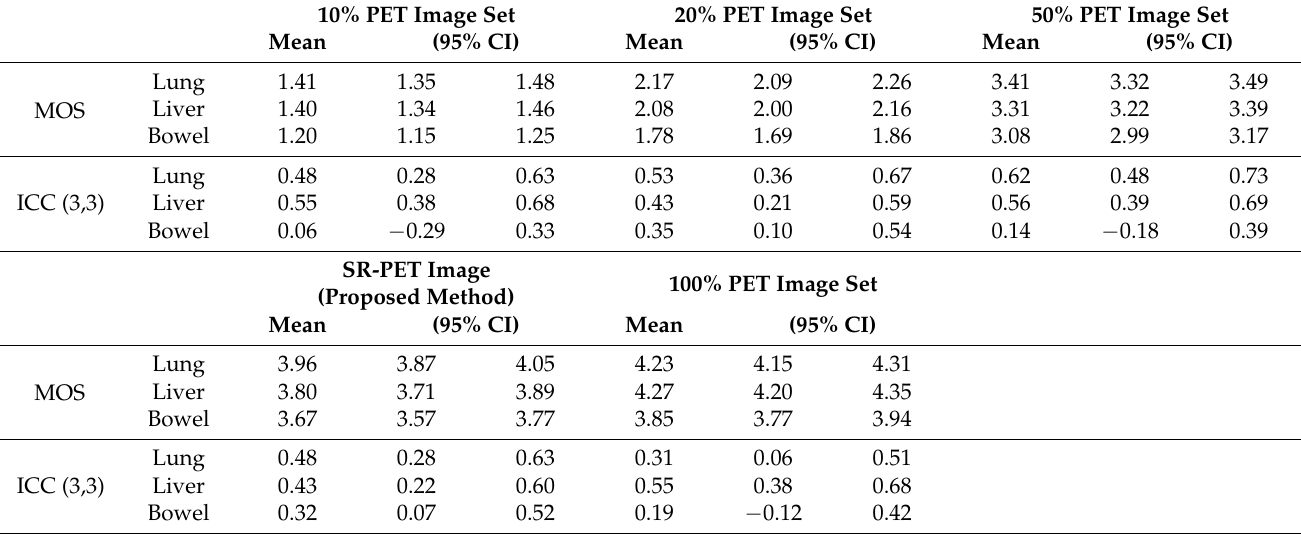
Table 2. Summary of the subjective evaluation of each image set.